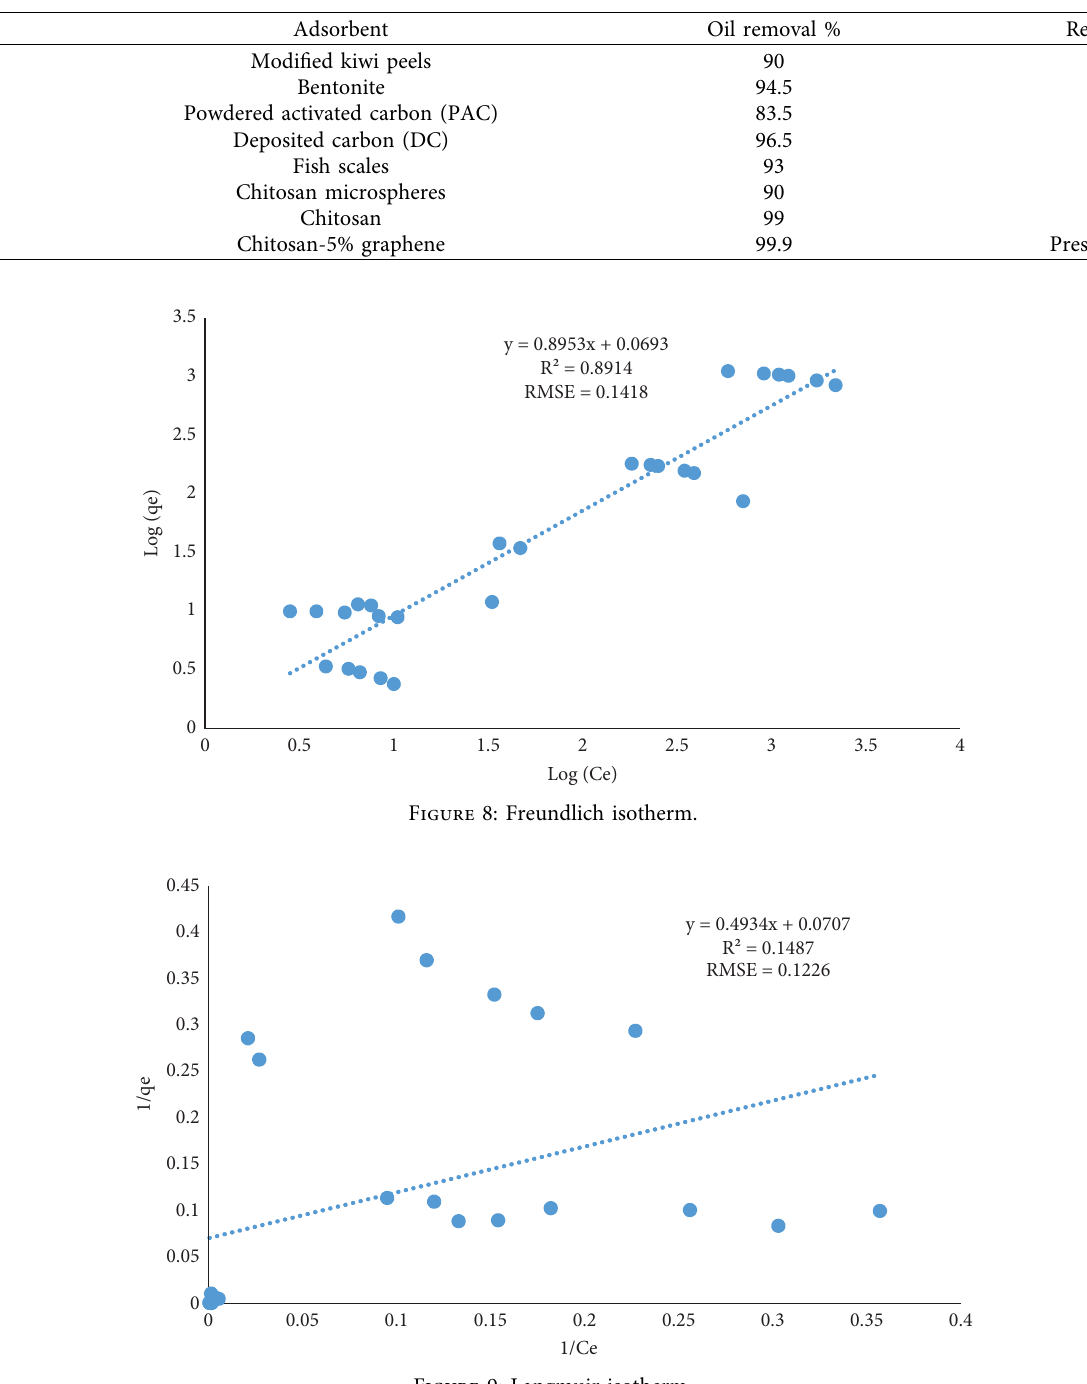
Table 2: Comparison of oil removal in present study with the literature.